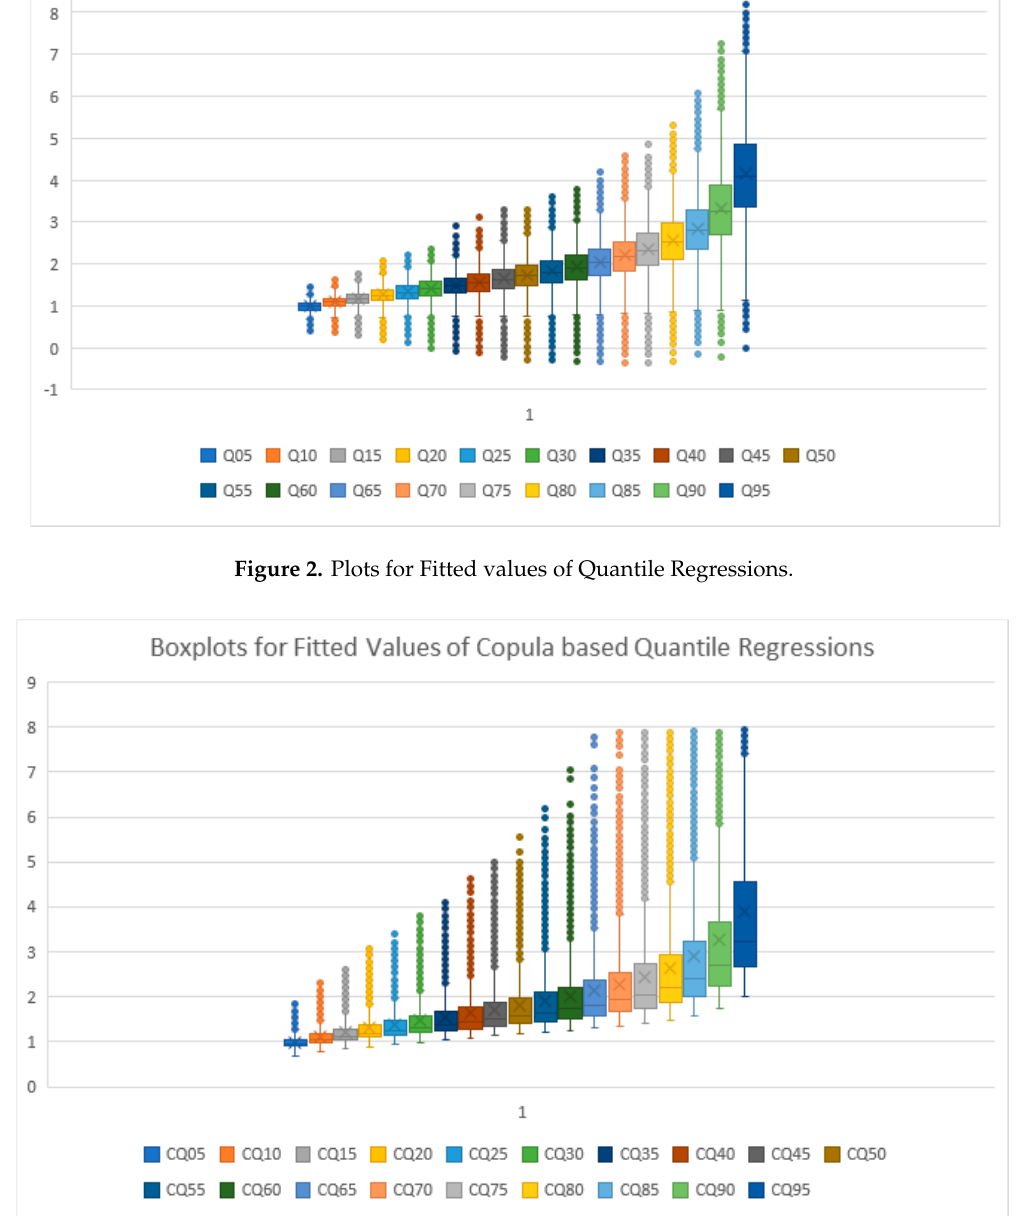
Figure 3. Plots for Fitted values of Copula based Quantile Regressions (Parametric).